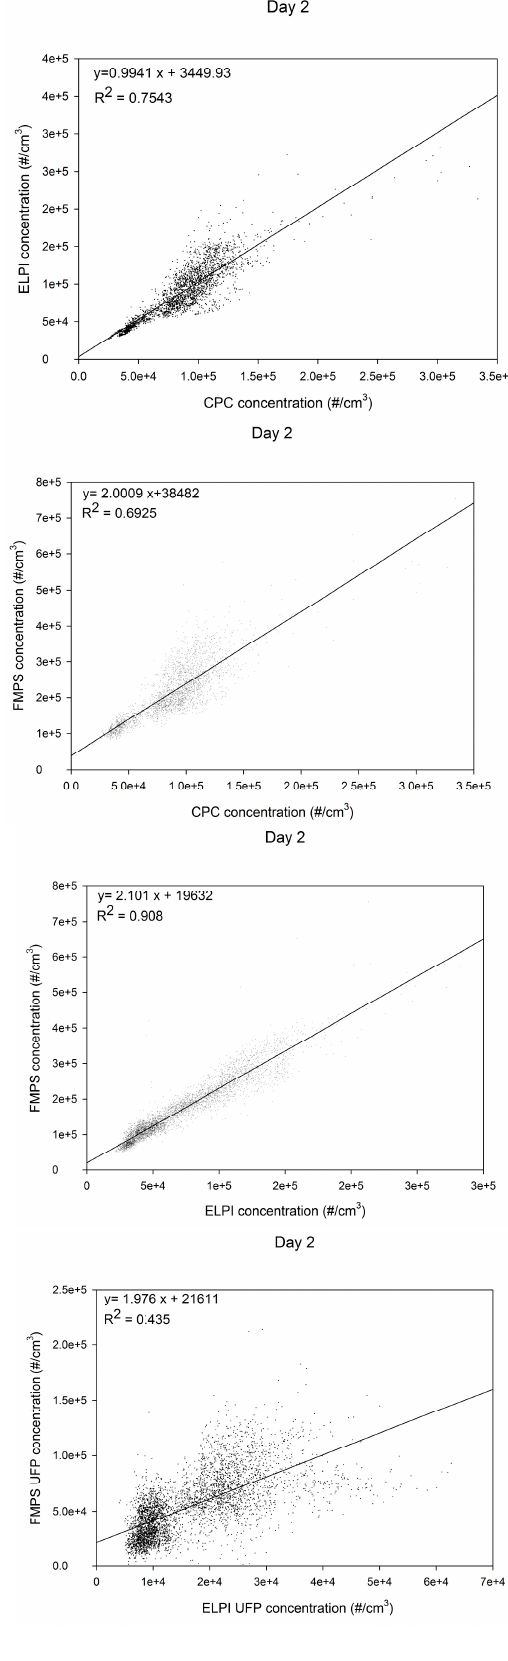
Figure 3 . Scatterplots of the particle concentrations of the different instruments together with regression analyses.